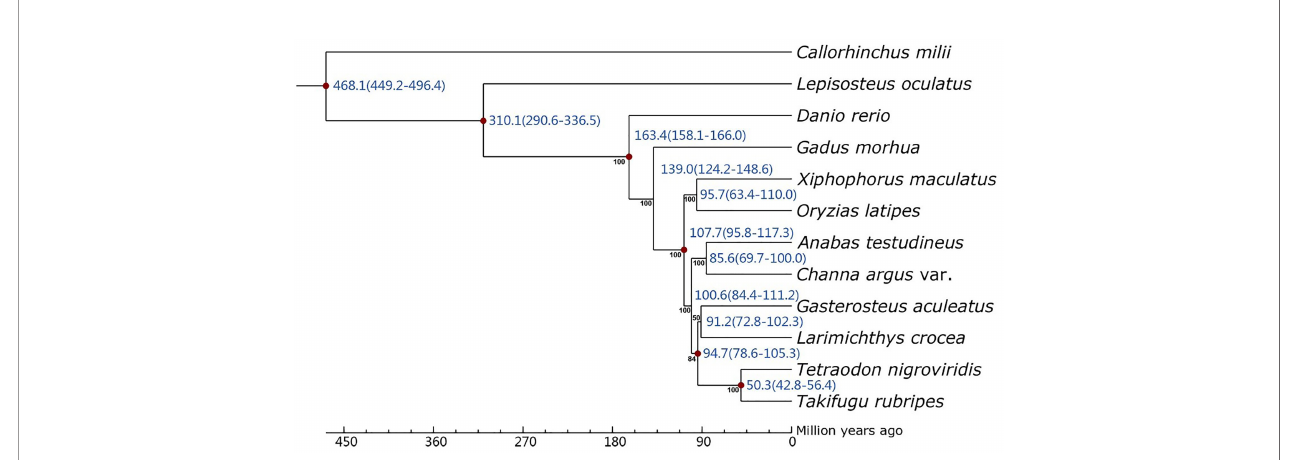
FIGURE 4 | Phylogenetic relationships of C. argus var. and other fi sh species. Black numbers near nodes are bootstrap values estimated from 100 times of resampling. Blue number near nodes are the estimated divergence times with the 95% con fi dence interval. Nodes marked with red denotes the calibration time